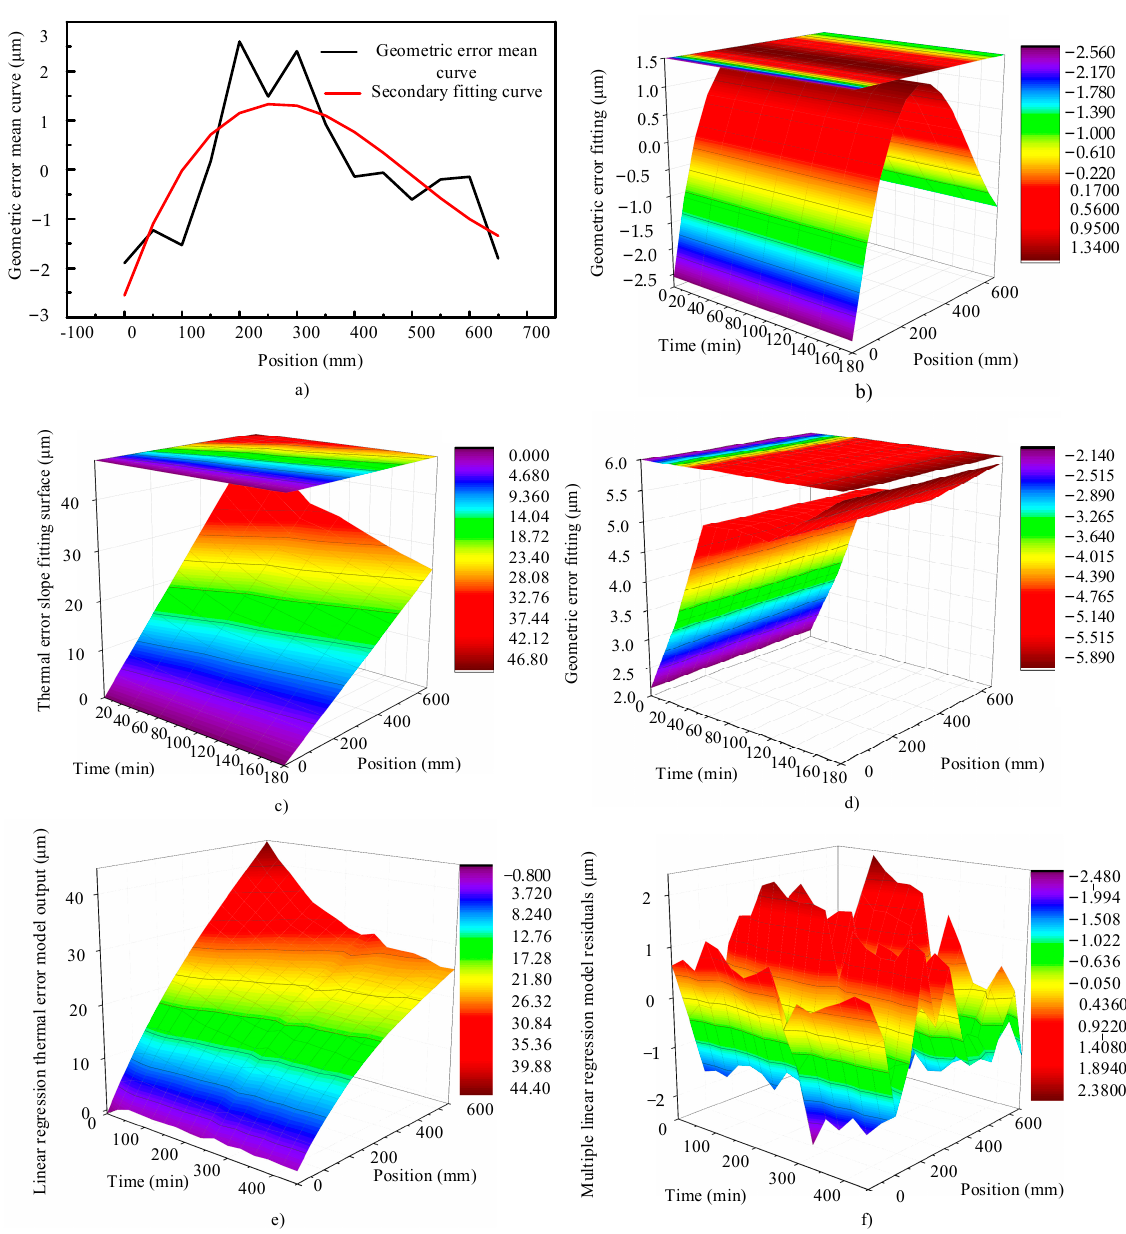
Figure 13. Multiple linear regression flow and residual comparison chart. ( a ) geometric error fitting; ( b ) geometric error fitting surface; ( c ) thermal error slope fitting surface; ( d ) surface of thermal error intercept fitting; ( e ) thermal error model fitting surface; ( f ) fitting residual